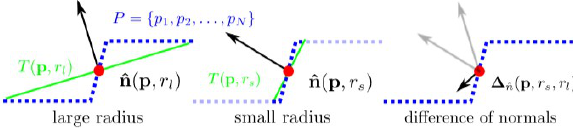
Figure 3. The meaning of large (left), small support radius (middle) and the calculated DoN operator (right) (Ioannou et al.,